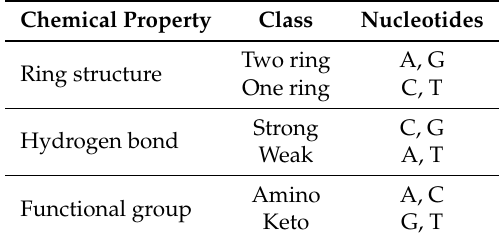
Table 2. Cluster of nucleotides based on chemical